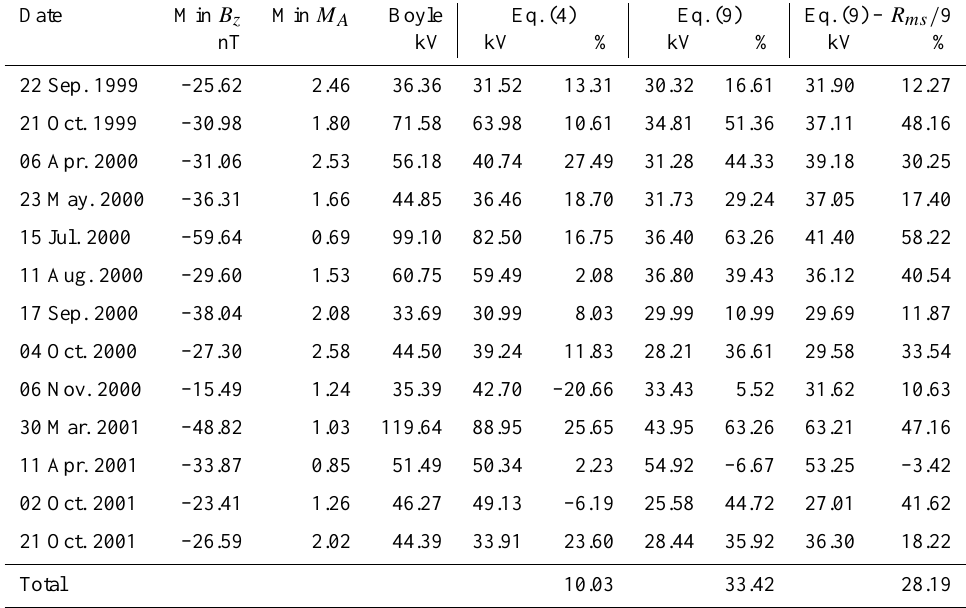
Table 1. A summary of the values associated with the 13 events. The columns are the event starting date, the minimum IMF B z during the period, the minimum Alfv´en Mach number, the RMS difference between the AMIE CPCP and the Boyle et al. (1997) formulation for the 48 hour period, the RMS error using Eq. (4), the decrease in the error using this formulation over the Boyle et al. (1997) formulation, the RMS error using Eq. (9), the decrease in the error over the Boyle et al. (1997) formulation, the RMS error using Eq. (9), but leaving out the R ms / 9 term, and the decrease in the error using this formulation over the Boyle et al. (1997) formulation.